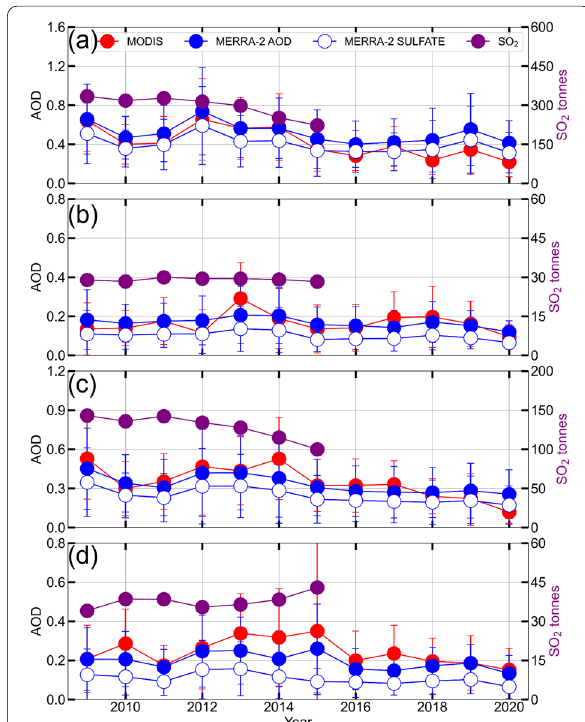
Fig. 6 Total and sulfate AODs and SO 2 emissions in a Southern China, b NWIC, c NEIC and d SIC from 2009 to 2020. Error bar: standard deviation; blue closed and open plots: total and sulfate AOD, respectively; red plot: MODIS AOD; purple plot: SO 2 emissions [tonnes]